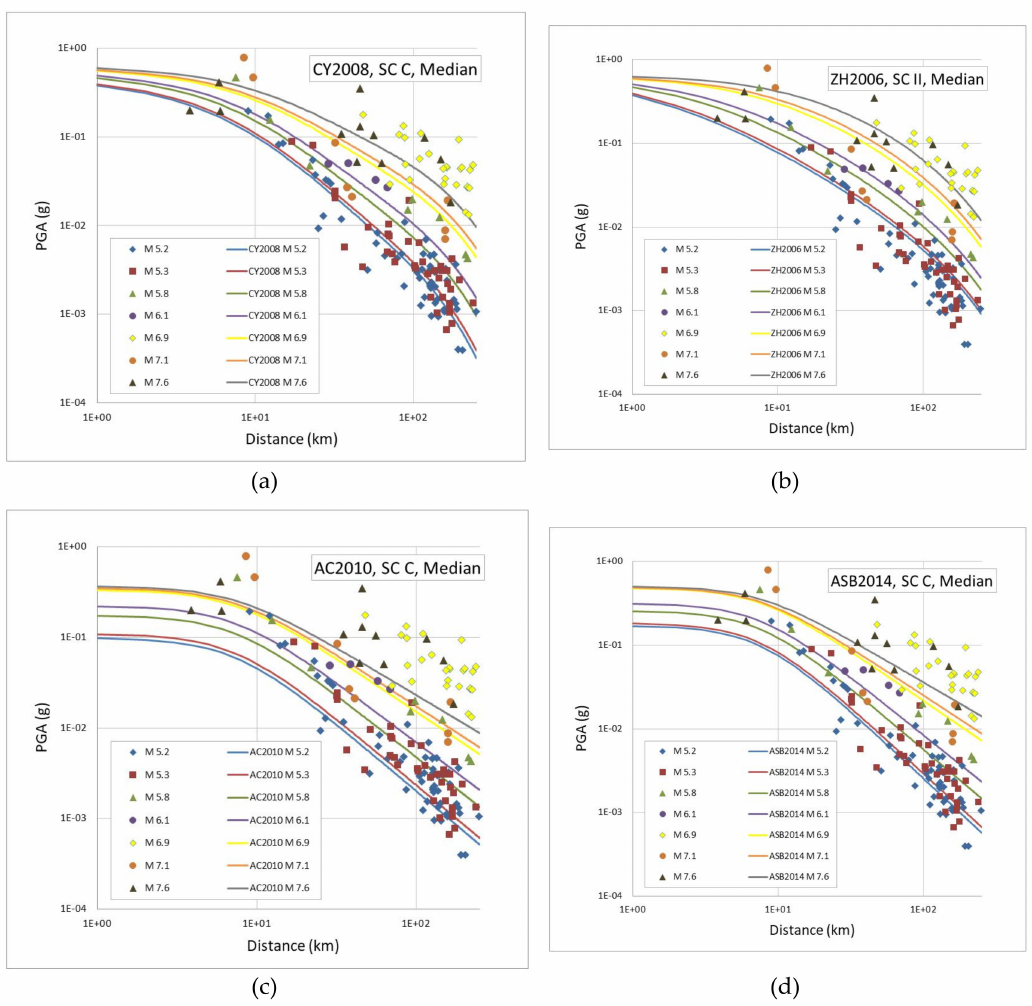
Figure 13. Comparison of all data from considered earthquakes with median, site class estimations from the four ground motion prediction models used in the GMPE logic tree: ( a ) CY2008, ( b ) ZH2006, ( c ) AC2010 ( d )